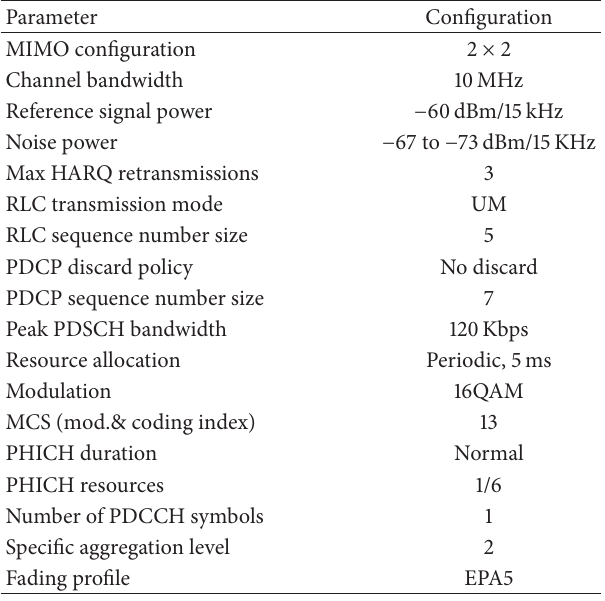
Table 1: Resource scheduling and radio frequency configuration in the LTE test base station.